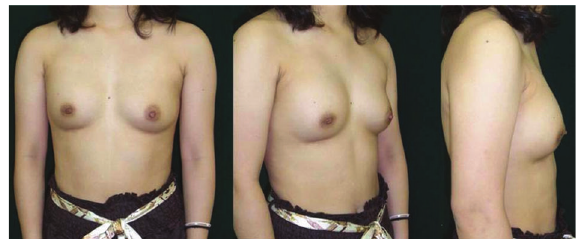
Figure 5: One year after operation, the positions of nipples and inframammary folds are symmetric.